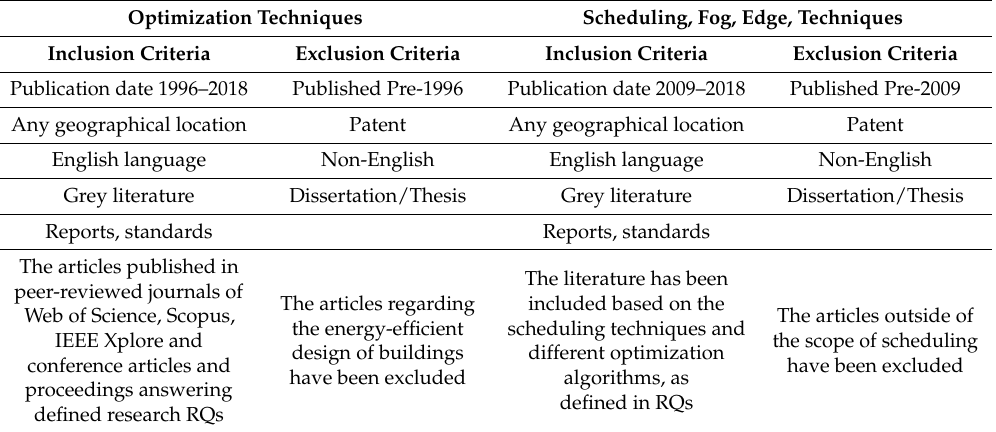
Table 2. Inclusion-exclusion criteria of